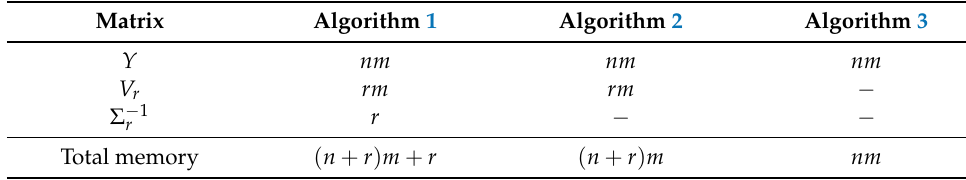
Table 3. Memory requirements for DMD mode